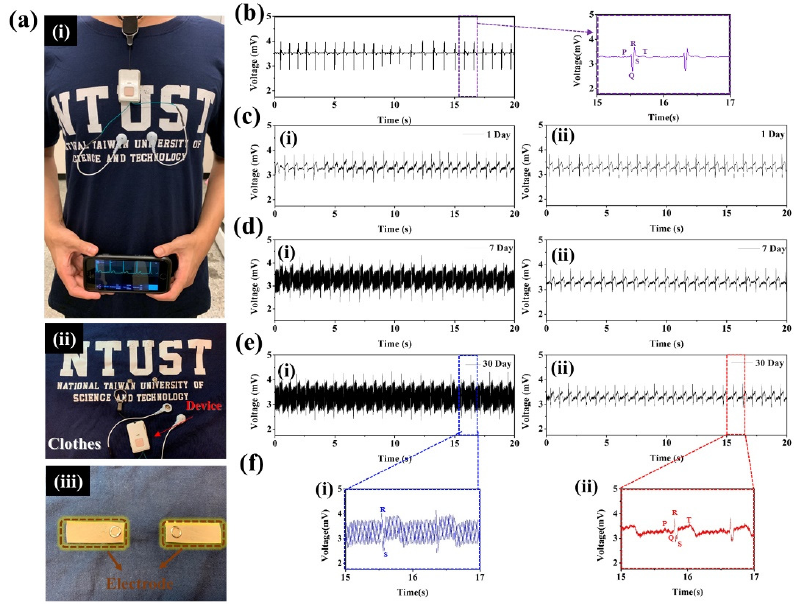
Figure 6. ( a ) (i) Digital image of CuNPs/PTT/GO films on smart clothing. (ii) External structure of ECG clothing, (iii) CuNPs/PTT/GO films on internal image of clothing. ECG signals collected. ( b ) Ag-Ag/Cl electrode and after ( c ) 1 day, ( d ) 7 days, and ( e ) 30 days and ( f ) 30-day signal enlargement, where (i) and (ii) represent CuNPs/PTT and CuNPs/PTT/GO film electrodes, respectively.